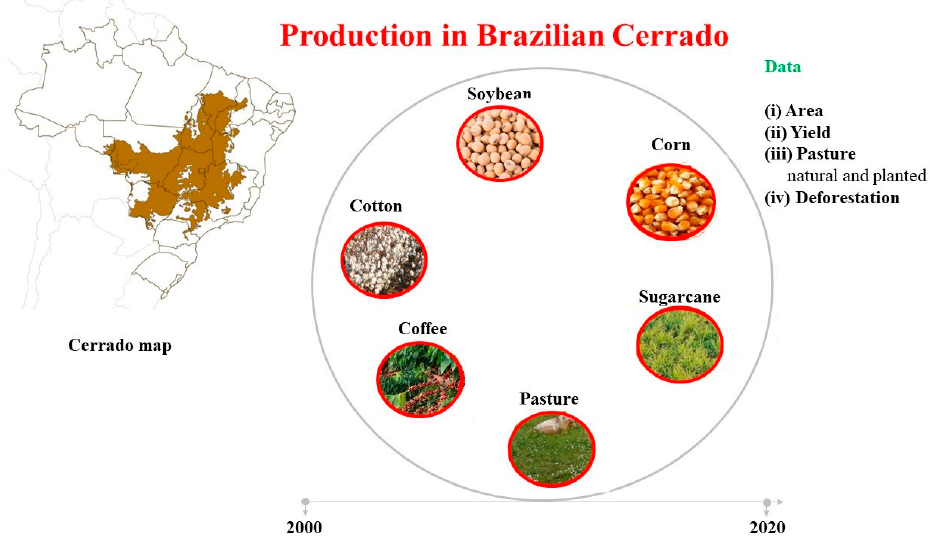
Figure 1. Design of study with the production profile of food (corn, soybean, sugarcane, and sugarcane) and fiber (cotton), and pasture (natural and planted) in Brazilian Cerrado from 2000 to 2020.